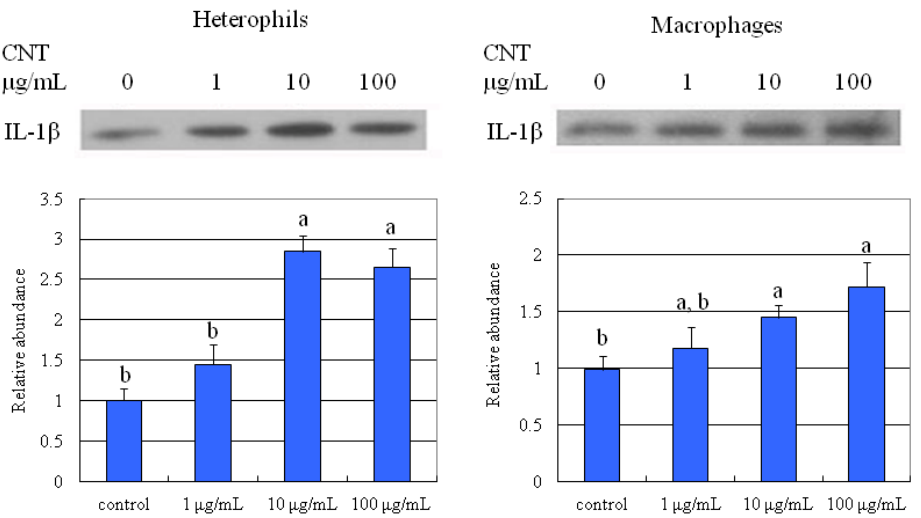
10. Carbon nanotube treatments promoted IL-1 β production of chicken macrophages and heterophils. Samples were subjected to 12.5% SDS-PAGE. The protein in the polyacrylamide gel was transferred to a nitrocellulose membrane. ( A ) The immunoblot was produced by incubating the membrane with antibodies against IL-1 β ; ( B ) The abundance of IL-1 β was analyzed with Total Lab ® . Values are the mean ± SE of three batches. a,b The means with different superscripts differ significantly ( p <